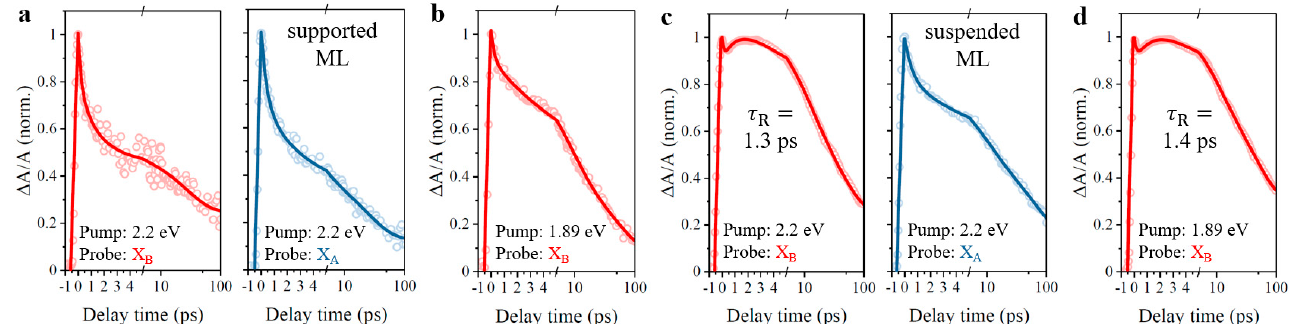
Figure 12. Pump-probe dynamics of supported and suspended monolayer MoS 2 . ( a , b ) Supported monolayer MoS 2 . ( c , d ) Suspended monolayer MoS 2 . ML, monolayer. X B , B-exciton resonance. X A , A-exciton resonance.